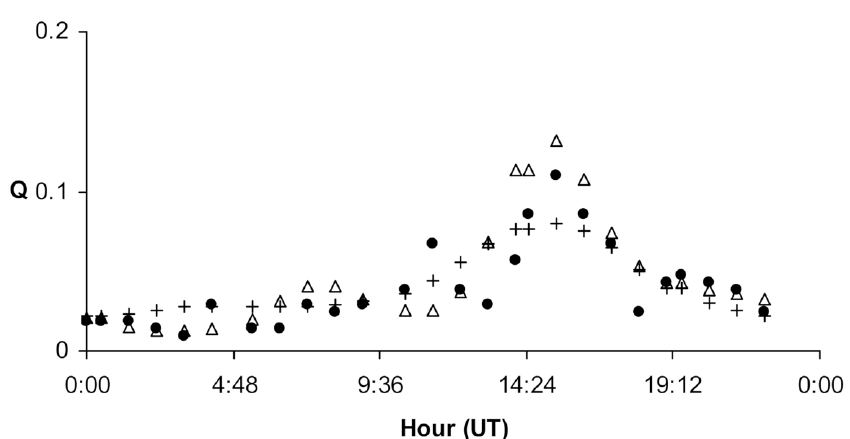
Figure 13. Allocation 53 at a threshold of 10 dB µ V/m.